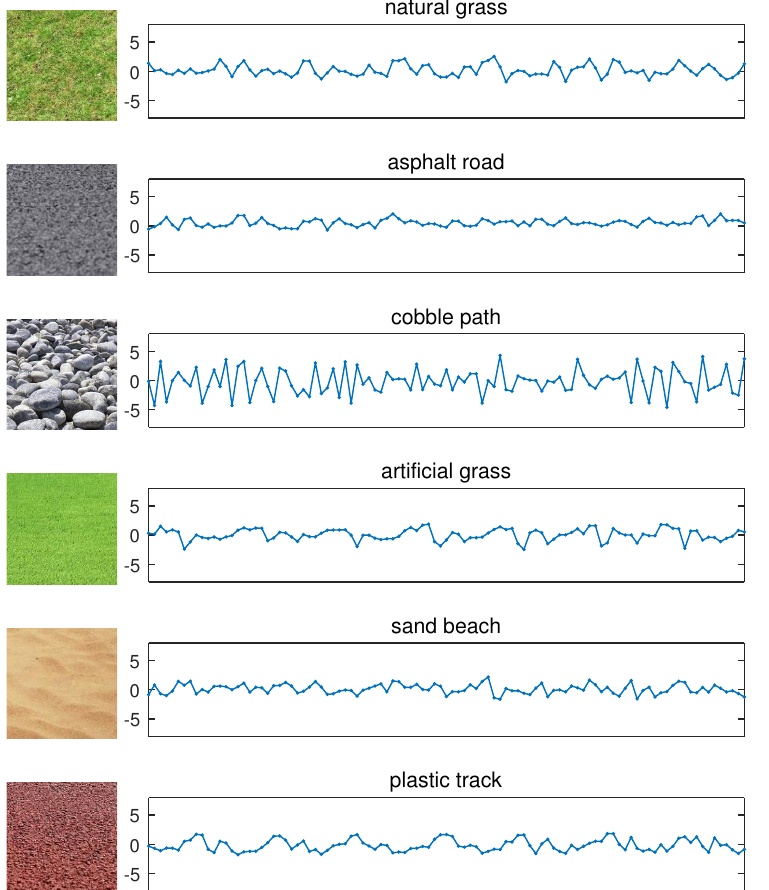
Figure 4. Photos of patches of terrains and the related vibration sub-sequences. From top to bottom, they are: natural grass (NG), asphalt road (AR), cobble path (CP), artificial grass (AG), sand beach (SB), plastic track (PT), respectively. The Y axis represents acceleration (m/s 2